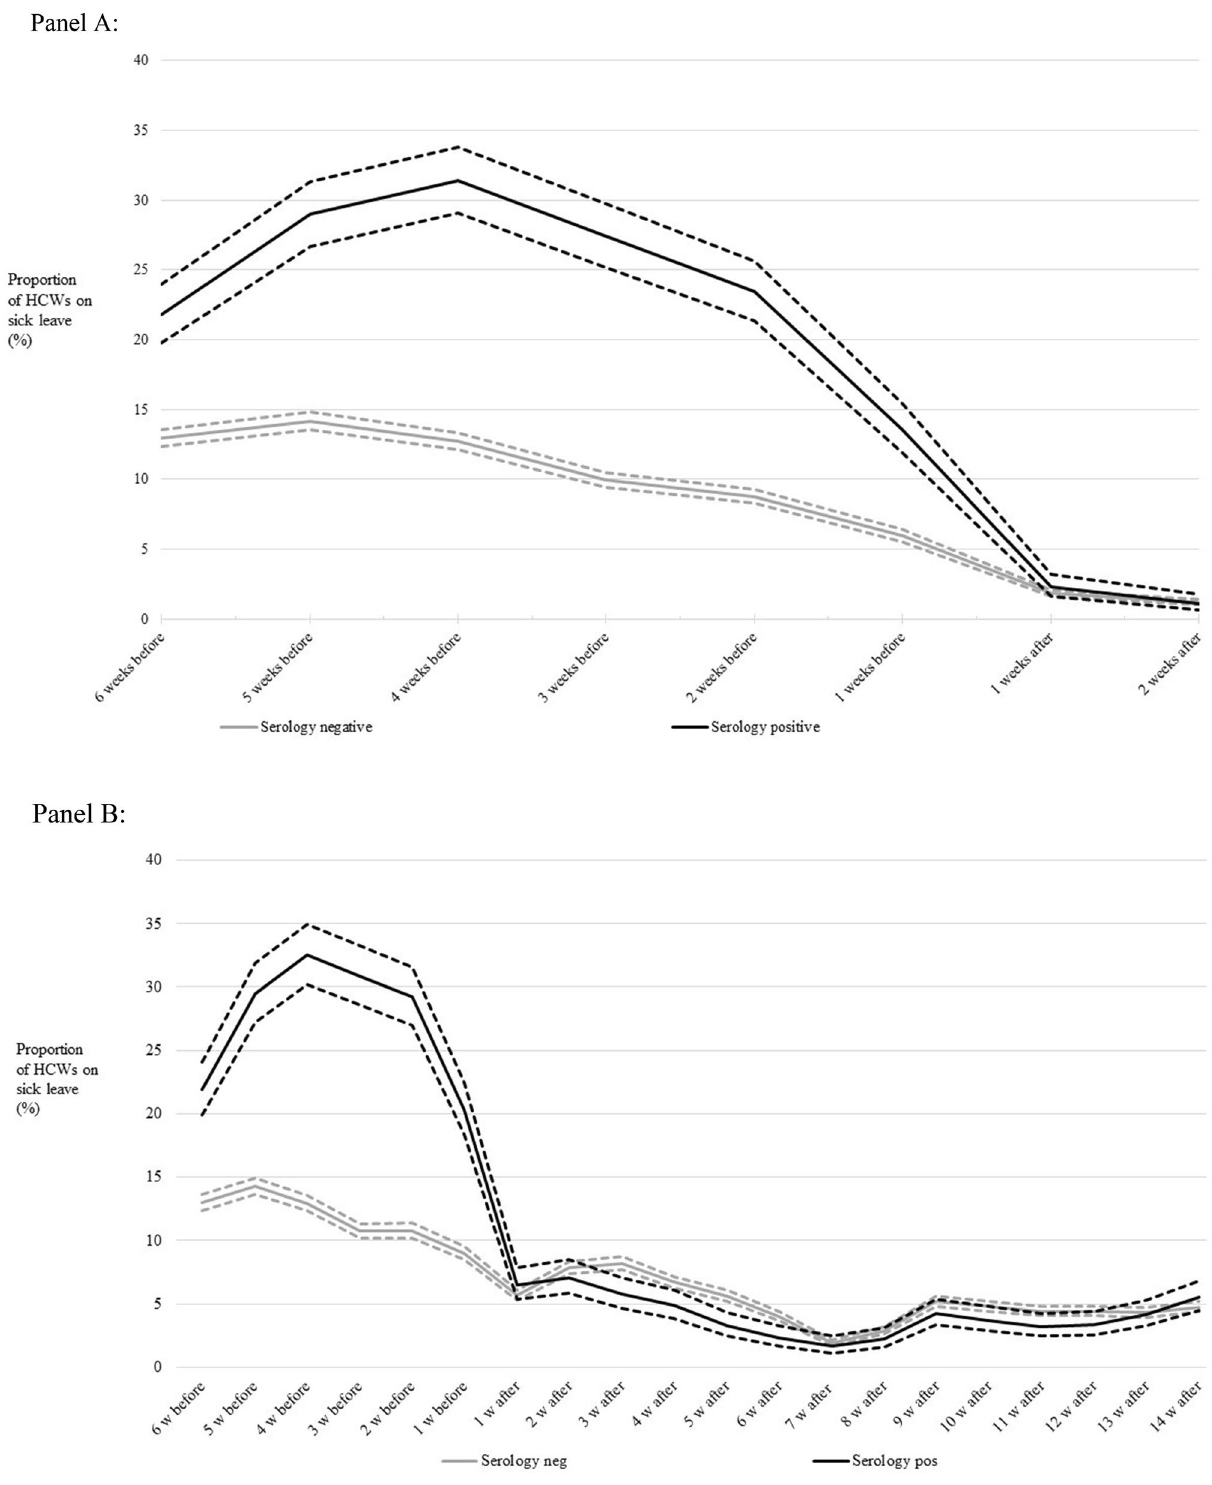
Figure 2. Proportion (%) of healthcare workers on sick leave during the study period, by serology test result. Dashed lines around the lines denote the 95% confidence intervals. ( A ) Follow-up restricted to the 2 weeks after testing when participants had no knowledge of testing results. ( B ) Follow-up up to 14 weeks after